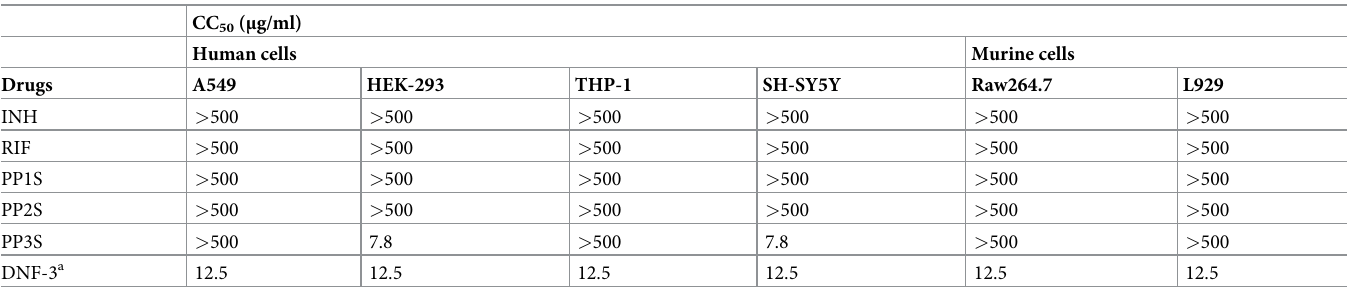
Table 2. CC 50 values of PPs against 6 different types of